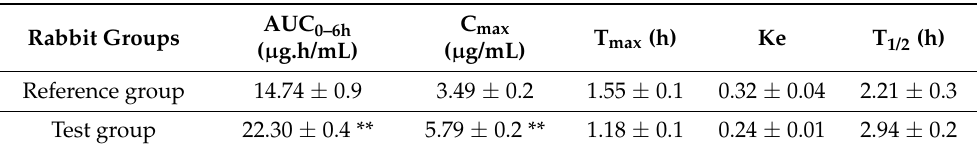
Table 1. Mean pharmacokinetic parameters obtained in the reference (AMX/Clav) and test groups (AMX/Clav/1,8-cineole) after the administration of treatments. **: statistically significant difference compared to reference group ( p <